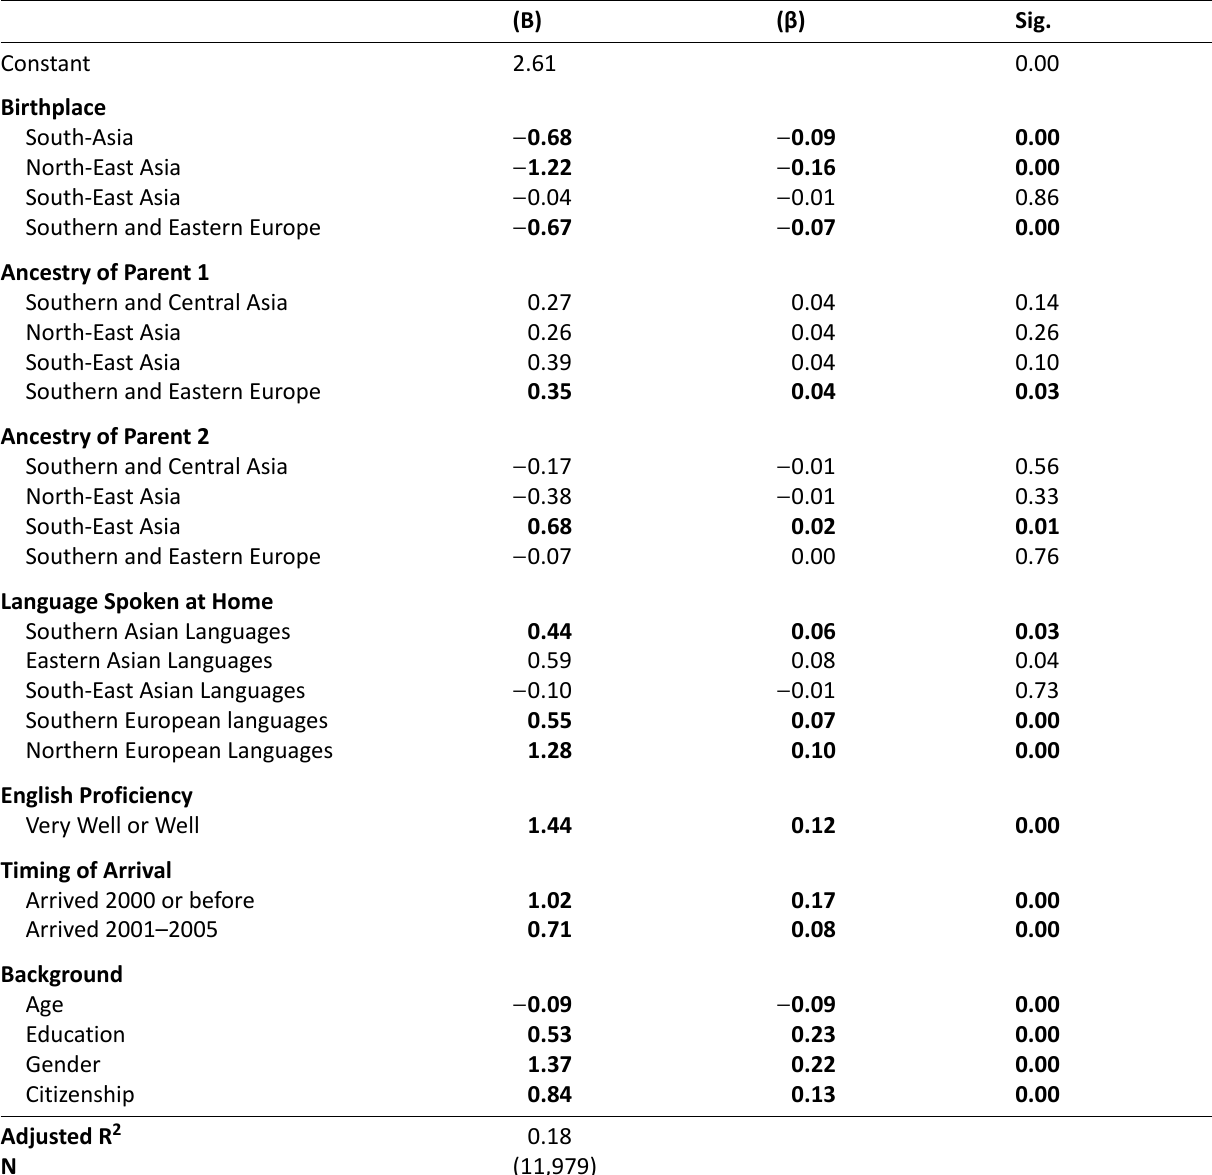
Table 5. OLS Regression Model estimating effects of origins and background on income, Census,